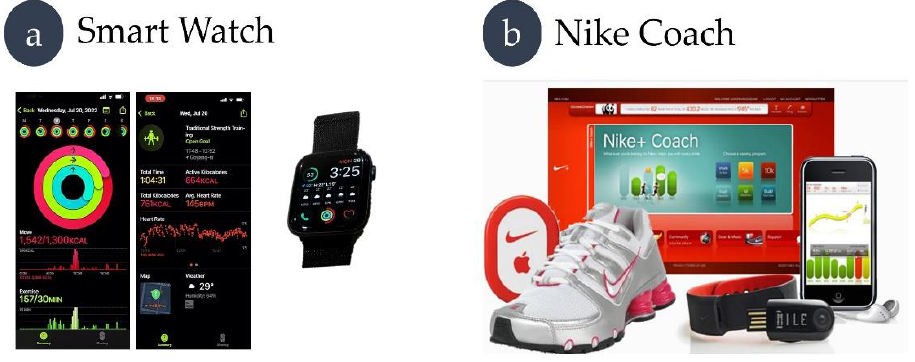
Figure 4. Practical physical education in lifelogging.